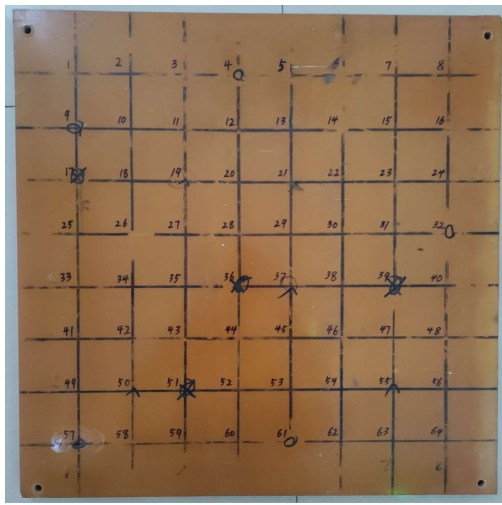
Figure 5. Grid layout on the composite plates.